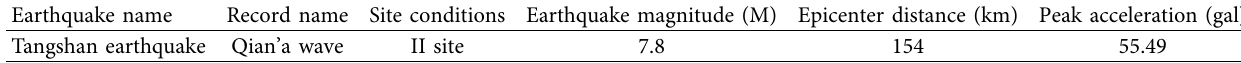
Table 1: Strong earthquake record information table.